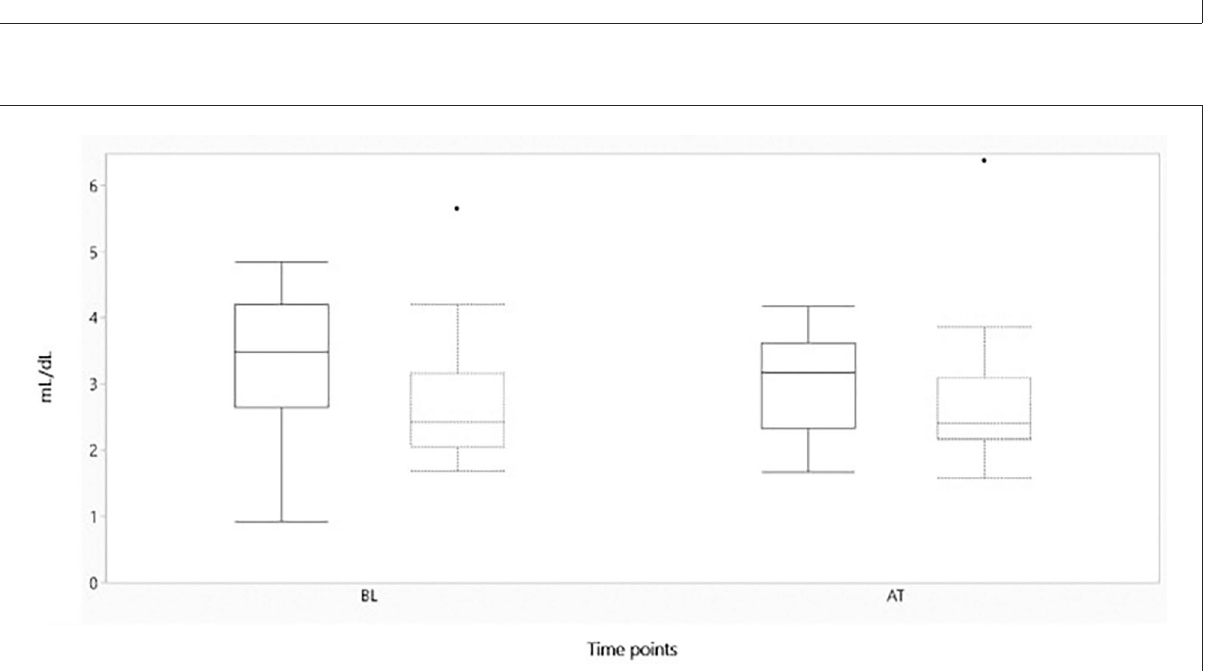
FIGURE3 Boxplot showing mean heart rate (min − 1 ) on the y-axis, before and after administration of either morphine or NaCl IV. The x-axis represents two baseline measurements with 1min interval and five measurements after administration with 1min interval. The solid line represents the morphine group and the staple line the placebo group. Boxplot characteristics: upper line = maximum value, excluding outliers, upper line of box = Q3 (75th percentile); middle line in box = median: lower line in box = Q1 (25th percentile) lower line = minimum value excluding outliers. BT, baseline; AT, after treatment. 1–5 = minutes before or after treatment.